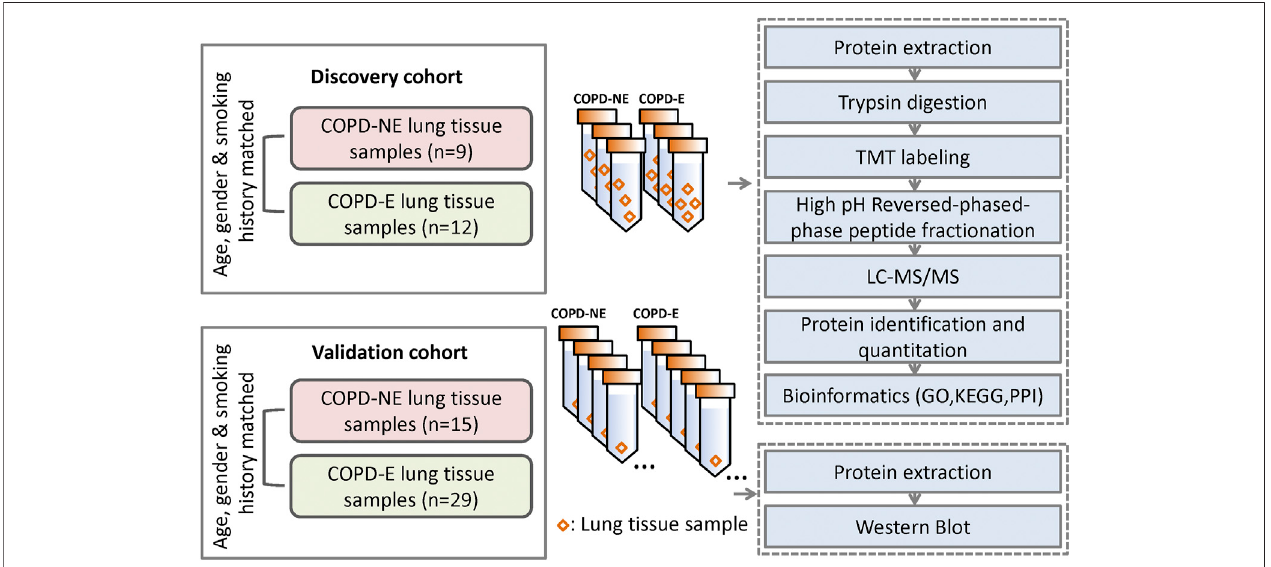
FIGURE 1 | Schematic diagram of tandem mass tag – based quantitative proteomic analysis . For the discovery cohort, every three tissue samples of COPD-NE patients were pooled together to form the three biological replicates in the COPD-NE group, and every four tissue samplesof COPD-E patients were pooled together to form the three biological replicates in the COPD-E group. Liquid chromatography-tandem mass spectrometry analysis was performed for the discovery cohort. For the validation cohort, every lung tissue samplewas used asan independentone. Westernblot wasperformed tovalidate theresults of liquid chromatography-tandem mass spectrometry analysis.